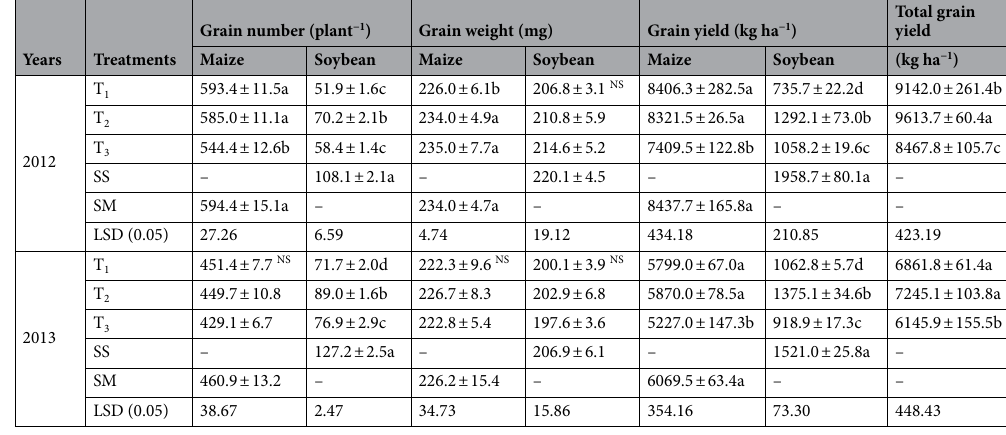
Table 5. Effect of different strip-width treatments on grain number, grain weight, grain yields of maize and soybean, and the total grain yield of maize/soybean relay intercropping system in cropping seasons from 2012 to 2013. Treatment codes represent narrow-strips (T 1 , 180 cm); medium-strips (T 2 , 200 cm); and wide-strips (T 3 , 220 cm) in maize/soybean relay intercropping system. SS is the sole cropping system of soybean, and SM is the sole cropping system of maize. Means are averages over three replicates ± standard error of the mean. Means that do not share the same letters in a column differ significantly at p ≤ 0.05 using least significant differences, calculated separately for each year. NS non-significant.